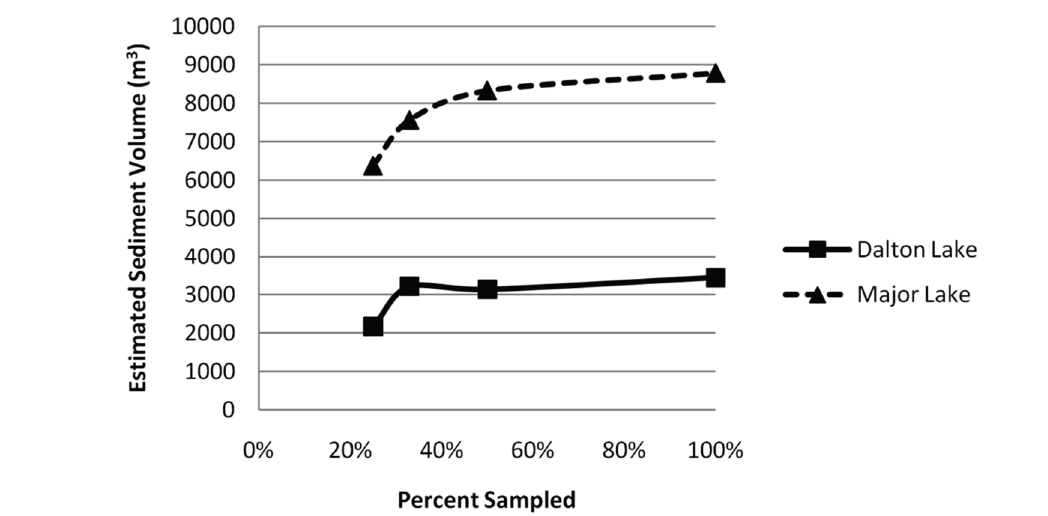
Figure 6. Plot of sediment predicted by differing sampling amounts from two sample lakes in the Black Hills of South